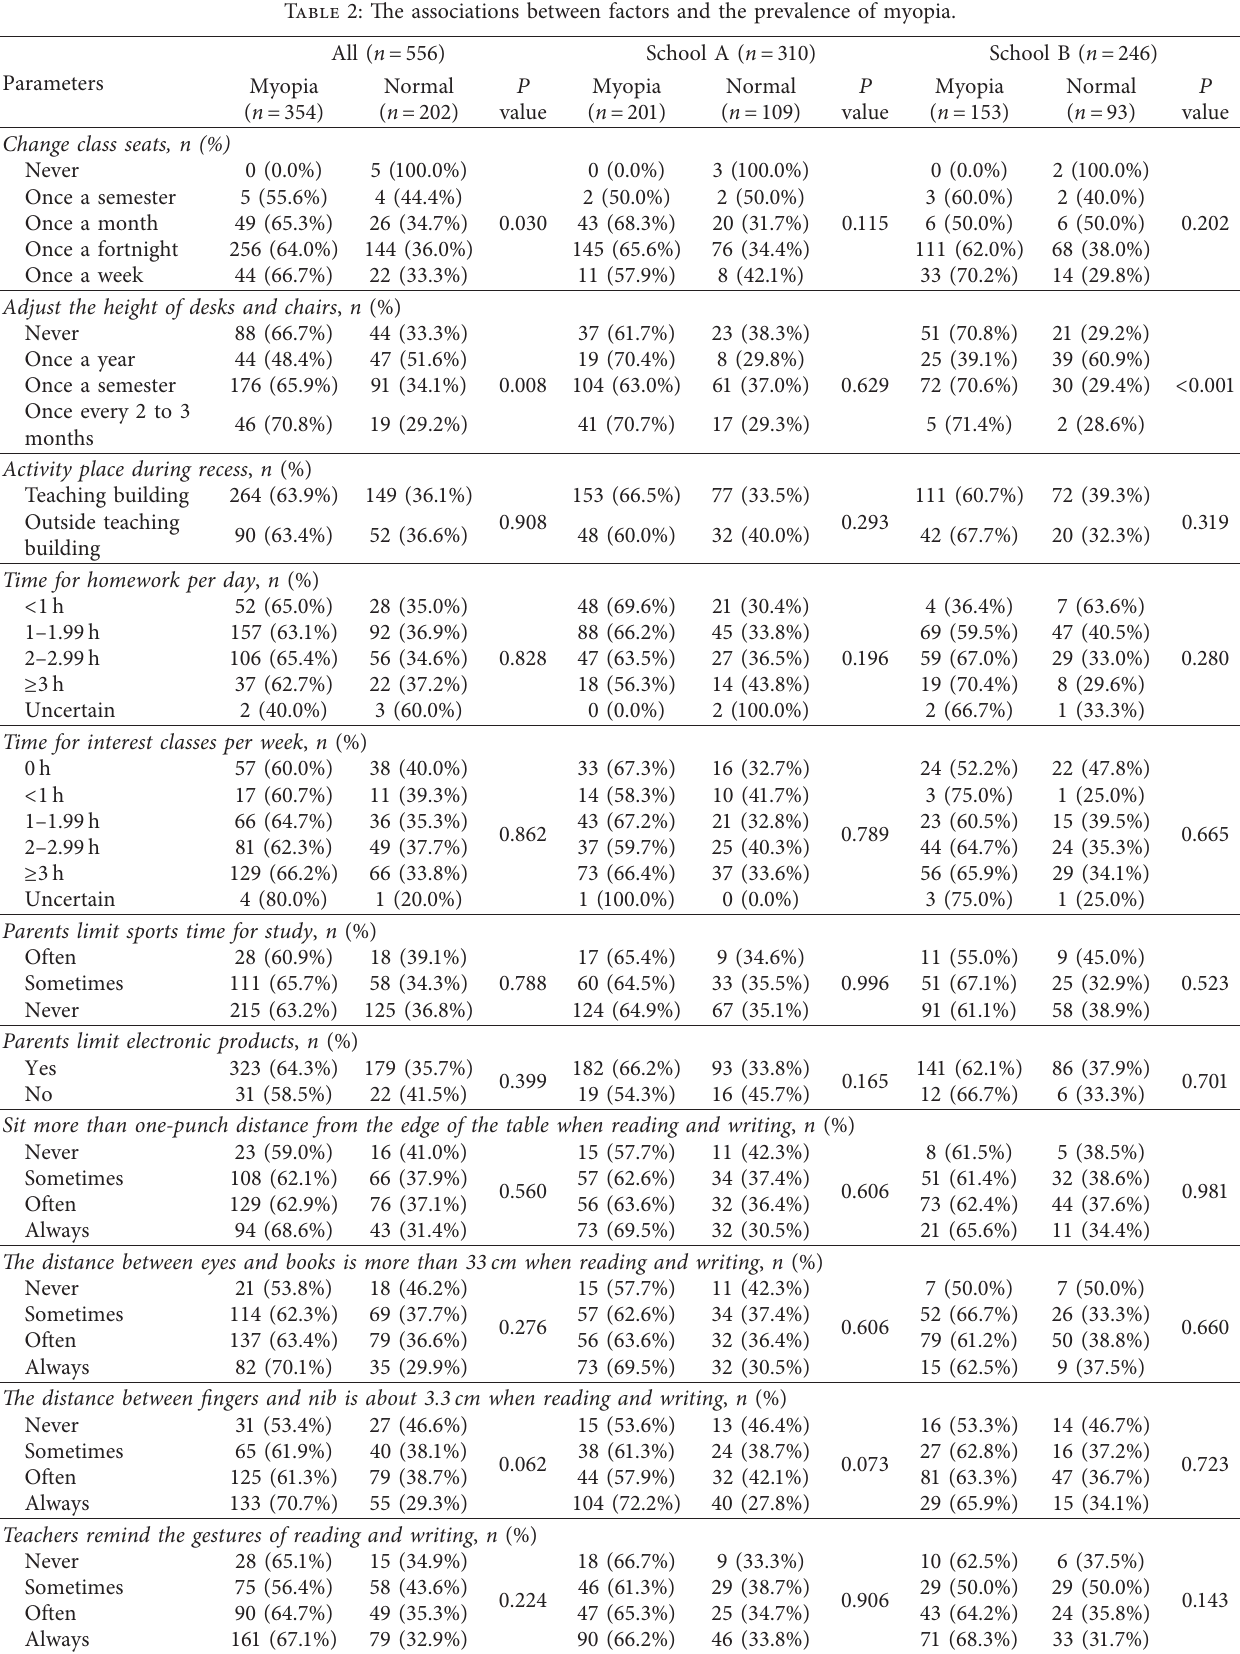
Table 2: The associations between factors and the prevalence of